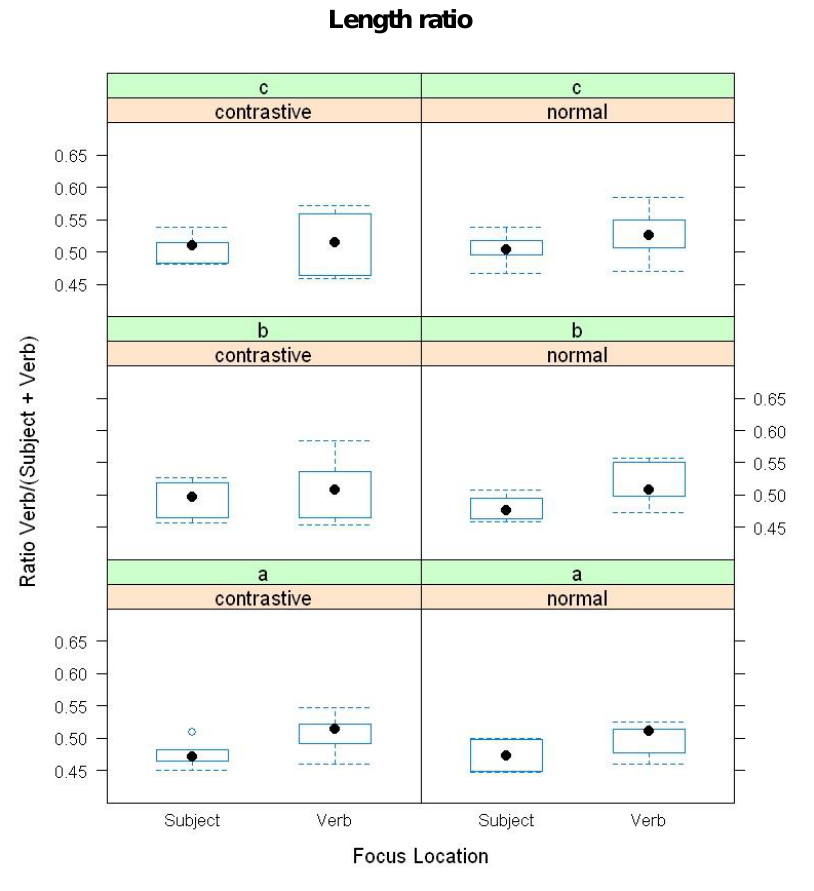
Figure 10. Boxplots of the ratio length_verb/(length_subject + length_verb) (y-axis) as a function of focus location (x-axis). Results are plotted separately for focus kind (columns) and sentence type